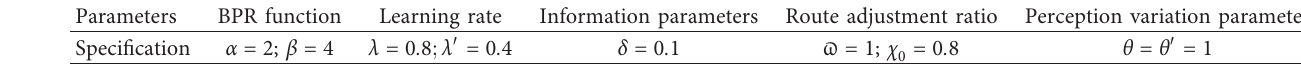
Table 2: Eigenvalues of J ∗